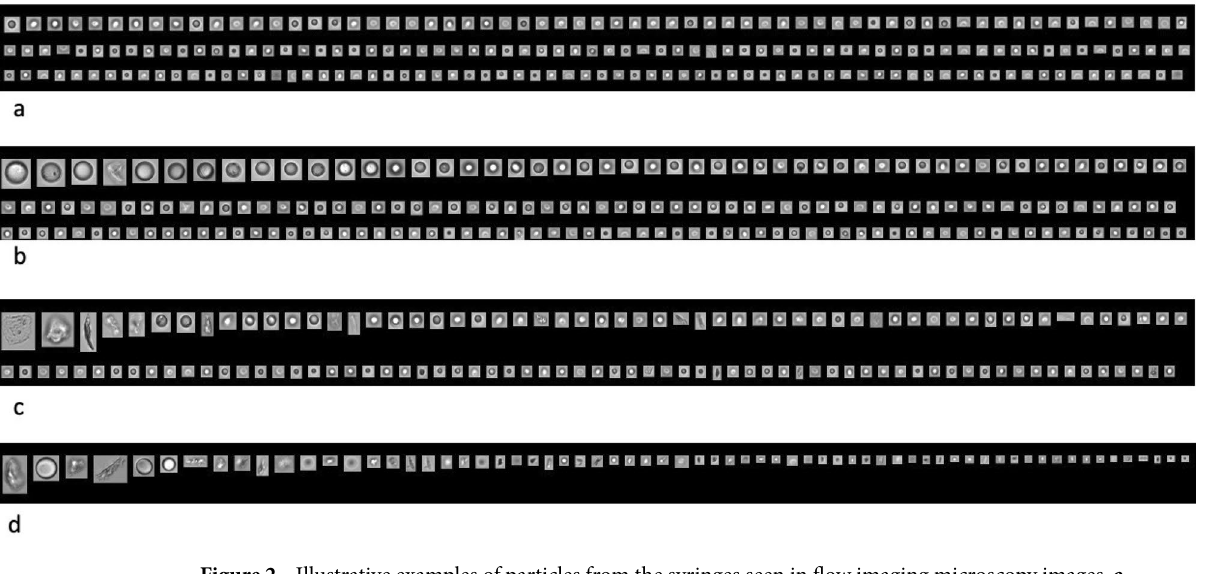
Figure 2. Illustrative examples of particles from the syringes seen in flow imaging microscopy images. a Circular particles from the HSW Norm-Ject, a silicone oil (SO)-free syringe, suggest oil-like lubricating components. b The BD Ultra-Fine, a siliconized syringe, with circular particles consistent with SO droplets. c Particles from the BD-Tuberculin syringe suggest fibrils. d Particles from the Saldanha Rodrigues, a siliconized syringe.